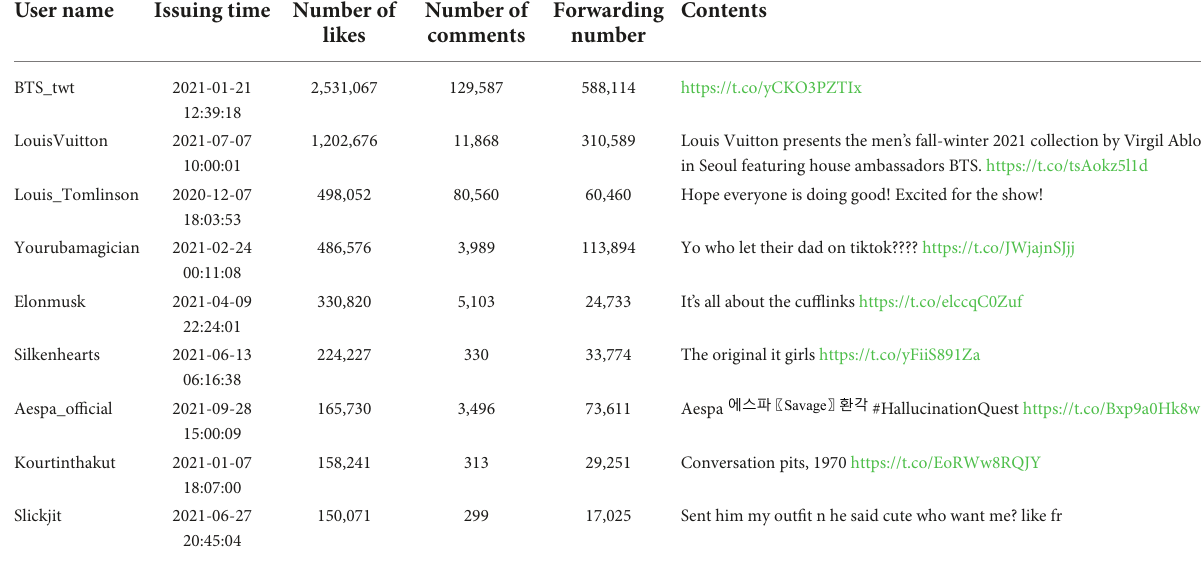
TABLE 2b Original posts collected by keyword “virtual fashion” on